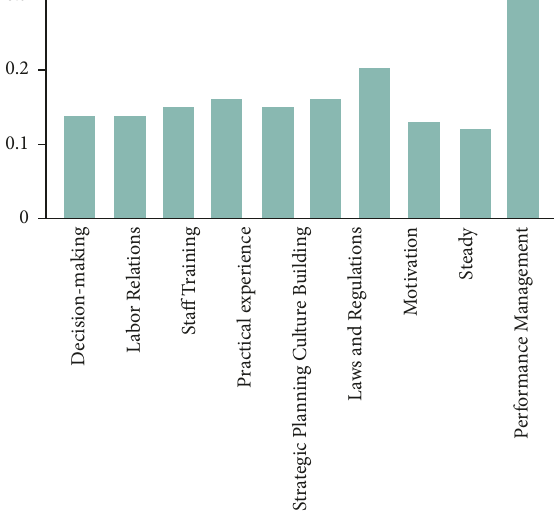
Figure 6: The top 10 competencies in demand by